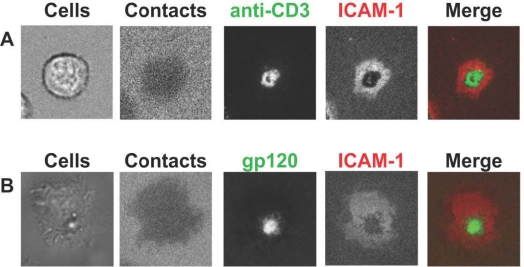
Morphological structures of IS versus HIV VS. (a) Mature IS is composed of a TCR-rich cSMAC and an adhesive pSMAC ring. (b) HIV VS displays a similar cSMAC and pSMAC segregation as observed in the IS, but the VS cSMAC is enriched with the virus envelope gp120.